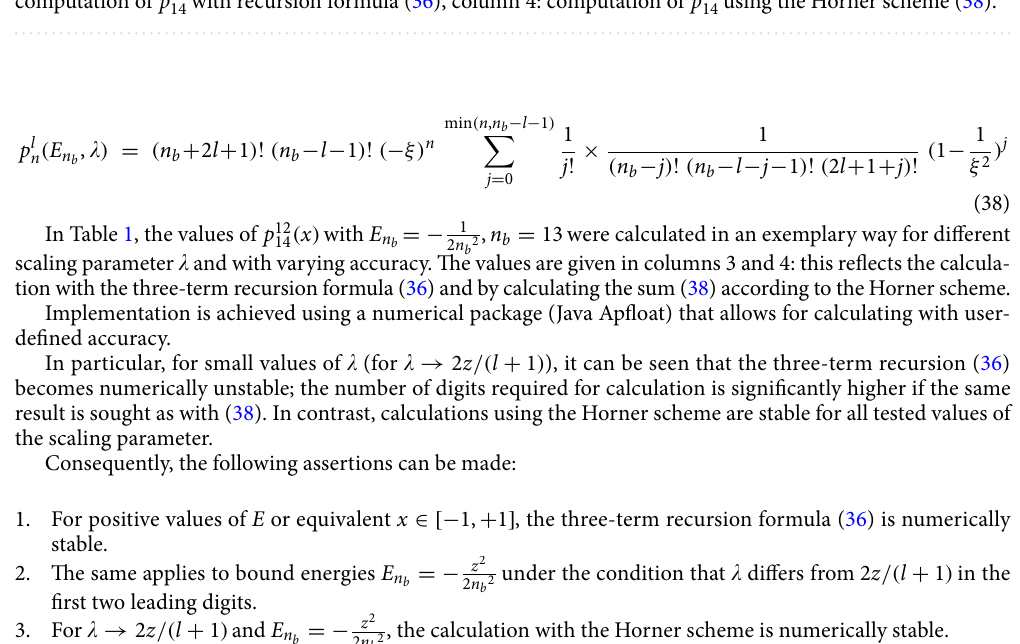
Table 1. Values for Pollaczek polynomial p 1 , n 1 . Column 1: scaling parameter (cid:31) , column 2: precision, number of digits, column 3: 13 , z E b = 2 2 n = − = b 12 computation of p 14 with recursion formula (36), column 4: computation of p